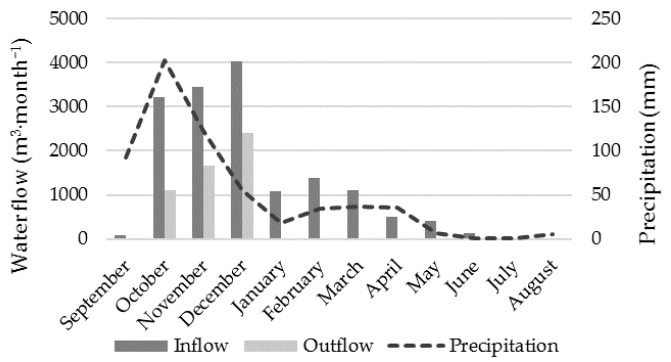
Figure 4. SFCW water flow and precipitation in the hydrological year 2005–2006.